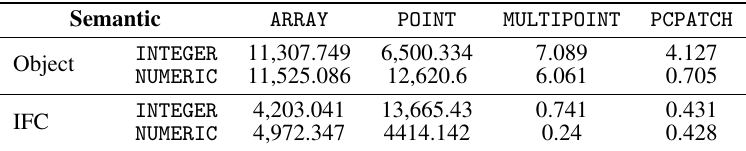
Table 3. Load all voxels for particular building.